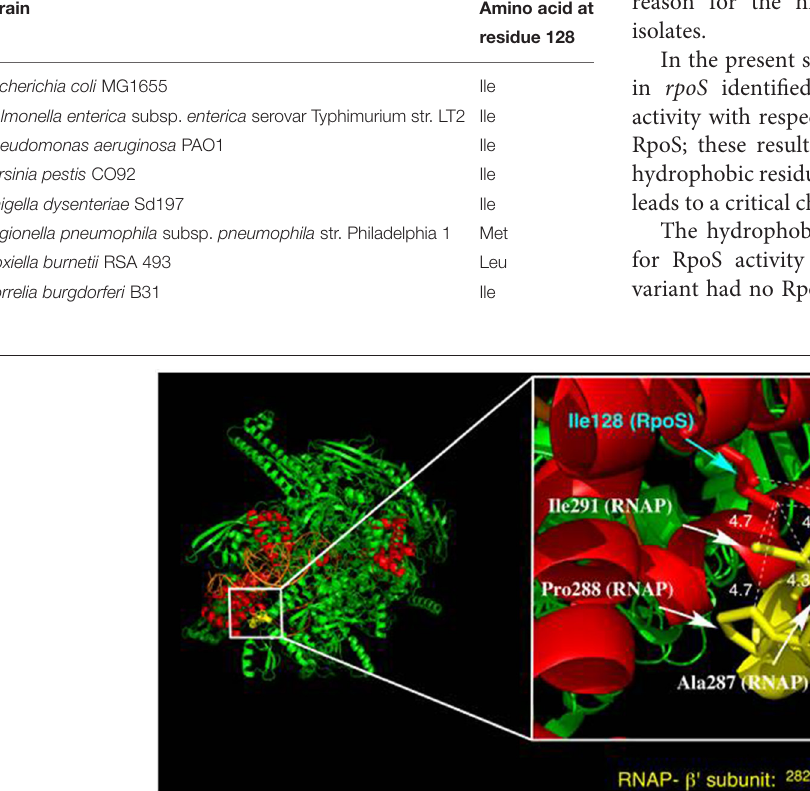
TABLE 2 | Amino acid at residue 128 of RpoS among various bacteria. Strain Amino acid at